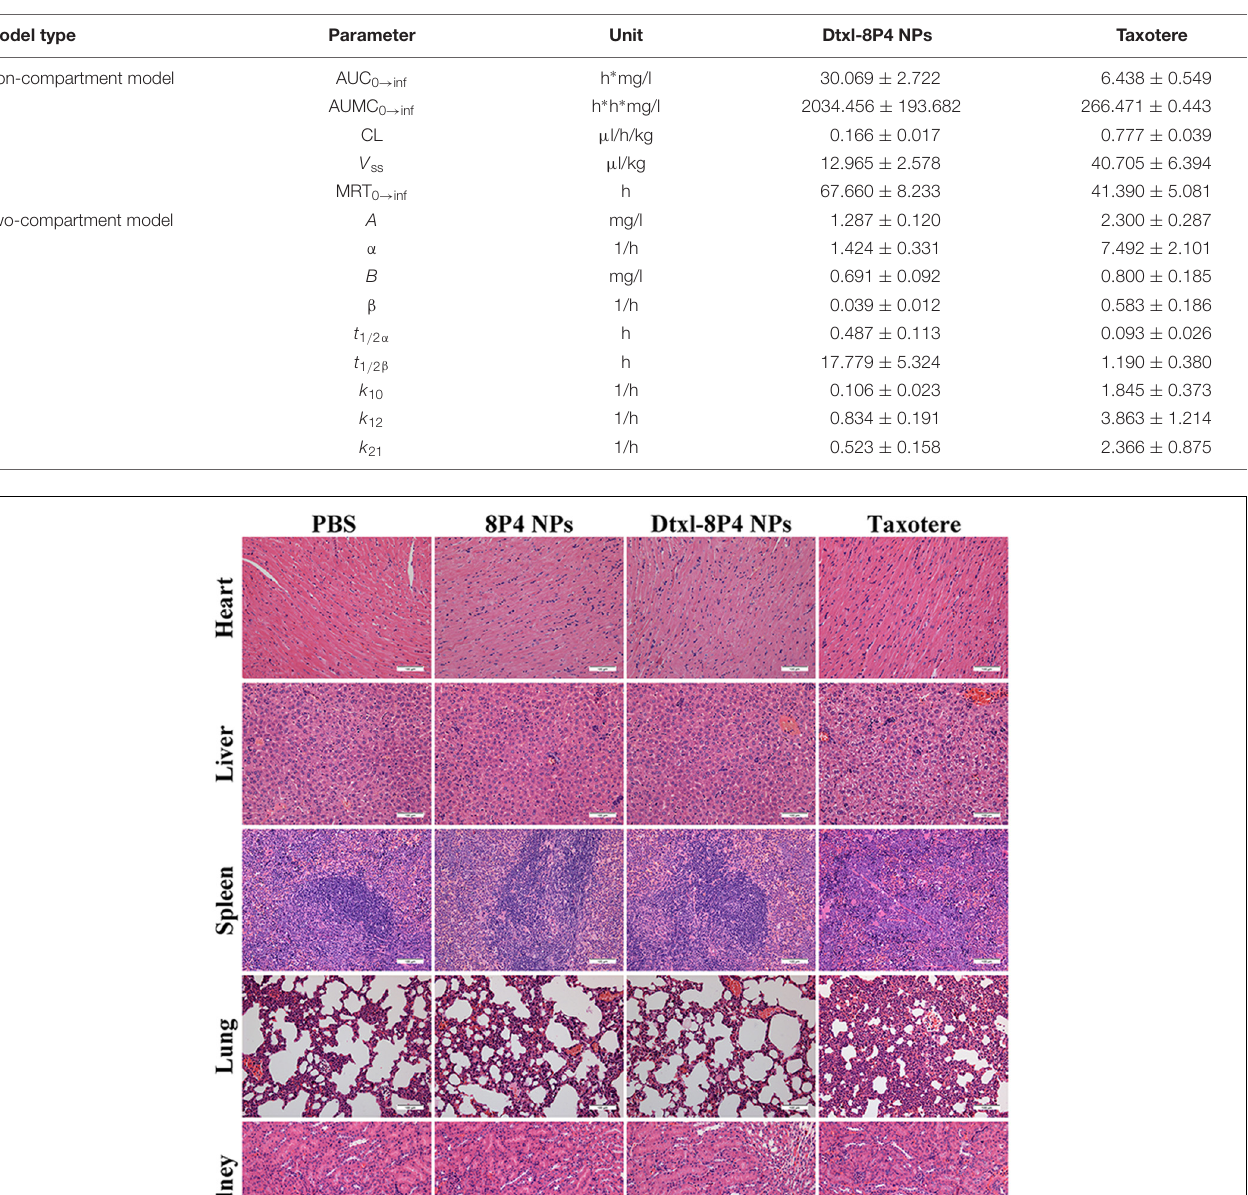
and inflammatory cell infiltration; splenic nodule atrophy; pulmonary hemorrhage; and tubular dilation with flattening of renal epithelium cells. However, no any noticeable histological alternations were captured in Dtxl-8P4 NPs as well as PBS and 8P4 NPs groups, confirming good